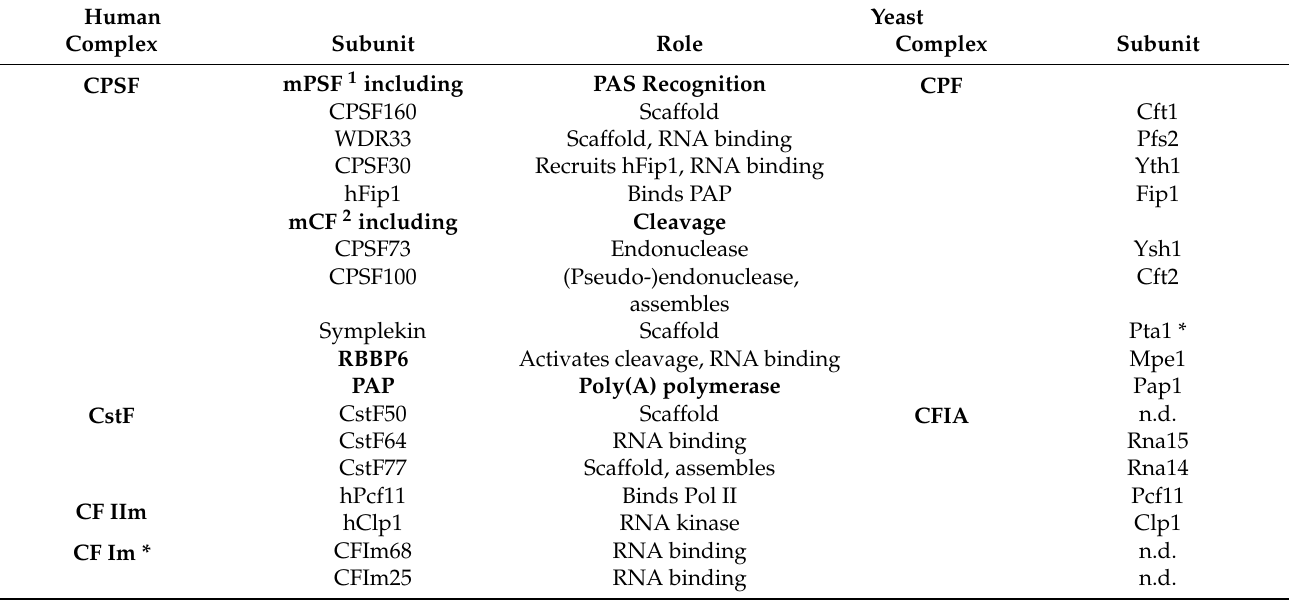
Table 1. Human and yeast mRNA 3 (cid:48) -end processing